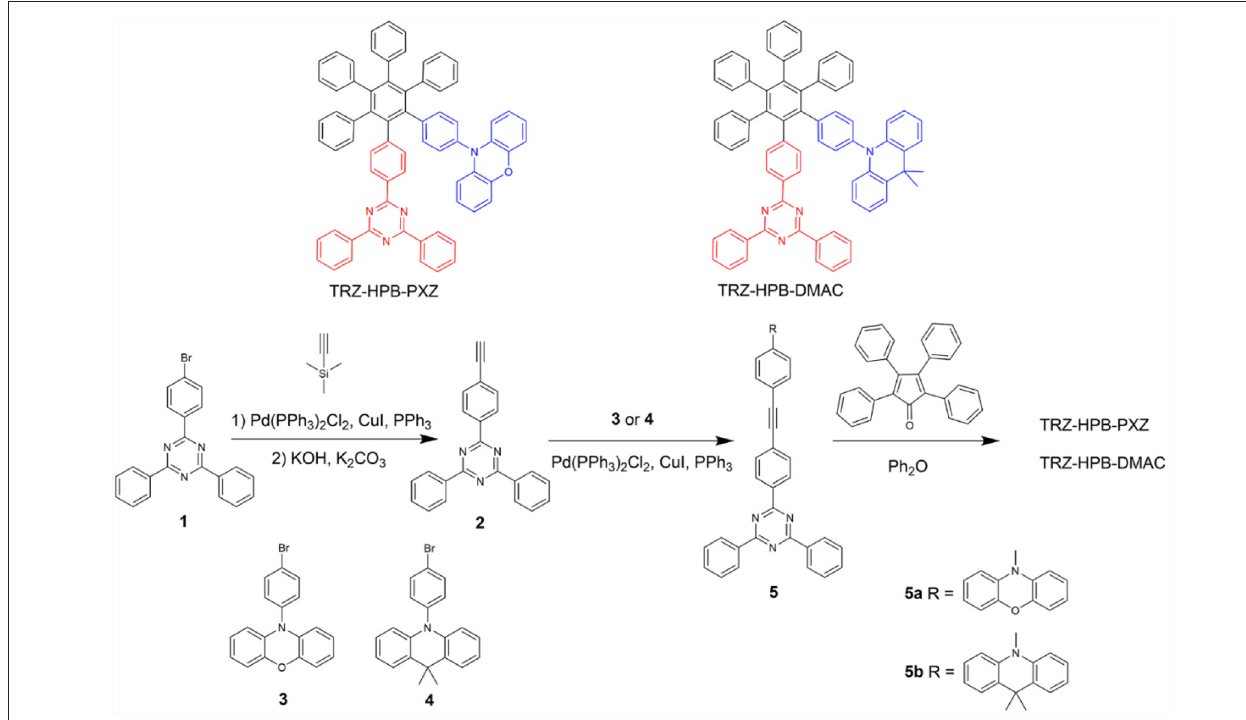
FIGURE 1 | (A) TGA curves of TRZ-HPB-PXZ and TRZ-HPB-DMAC, recorded under nitrogen at a heating rate of 20 ◦ C min − 1 . (B) Cyclic voltammograms of TRZ-HPB-PXZ and TRZ-HPB-DMAC, measured in acetonitrile containing 0.1M tetra- n -butylammonium hexafluorophosphate. Scan rate: 100 mV s − 1 .